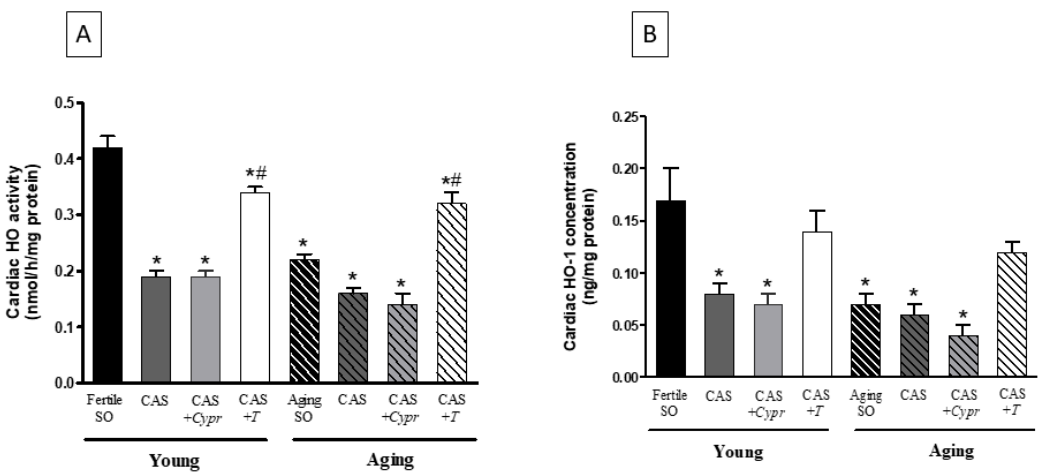
Figure 2. ( A ) The e ff ects of aging, surgical castration, and testosterone replacement therapy on the cardiac HO activity (HO; expressed as nmol bilirubin / h / mg protein). The results are shown as the means ± S.E.M. n = 7–9. ( B ) The e ff ects of aging, surgical castration, and testosterone replacement therapy on the cardiac HO-1 concentration (HO-1; expressed as ng / mg protein). The results are shown as the means ± S.E.M. n = 4–7. * p < 0.05: Statistical significance relative to the Young / SO fertile group, # p < 0.05: Statistical significance between age-matched CAS and CAS + T groups, CAS = surgical castration, T = testosterone replacement therapy, Cypr = cyproterone acetate treatment, and SO = sham operation.